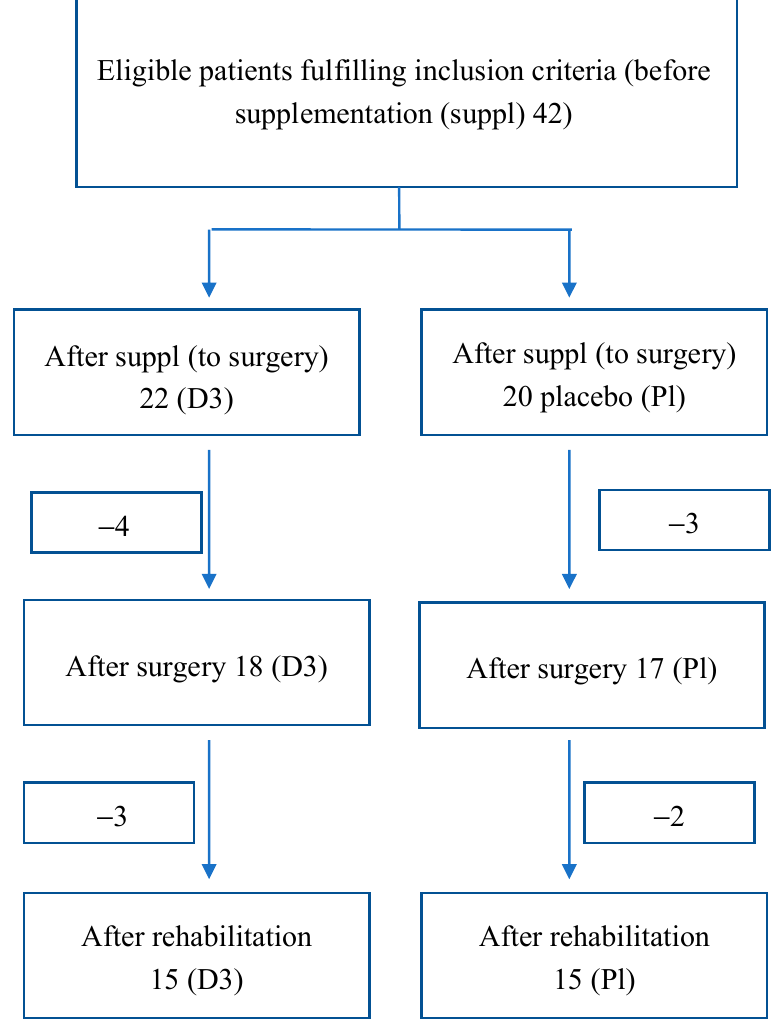
Figure 1. Participants flow diagram.